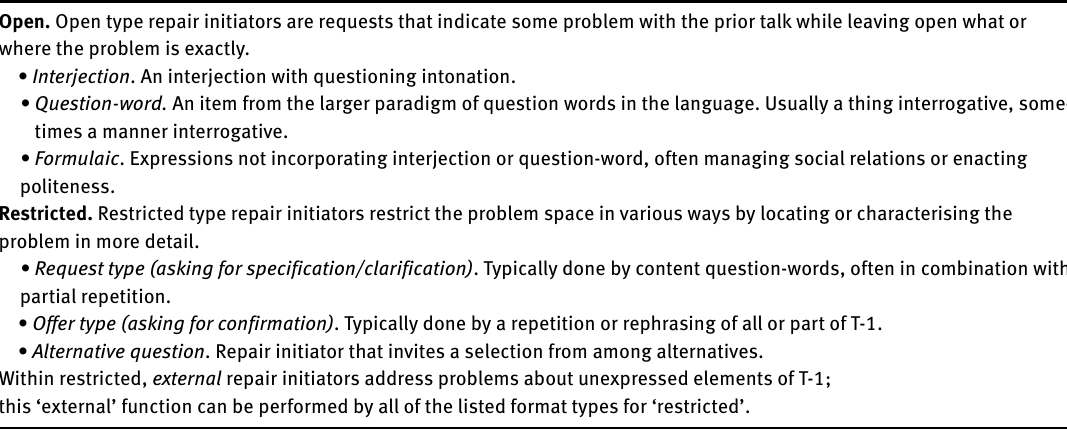
Table 2: Some basic format types for other-initiation of repair